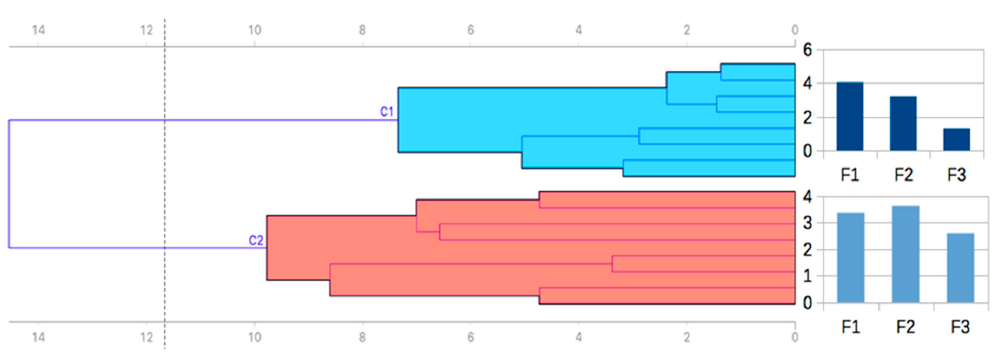
Figure 3. Cluster applying Ward’s method and mean factor scores.